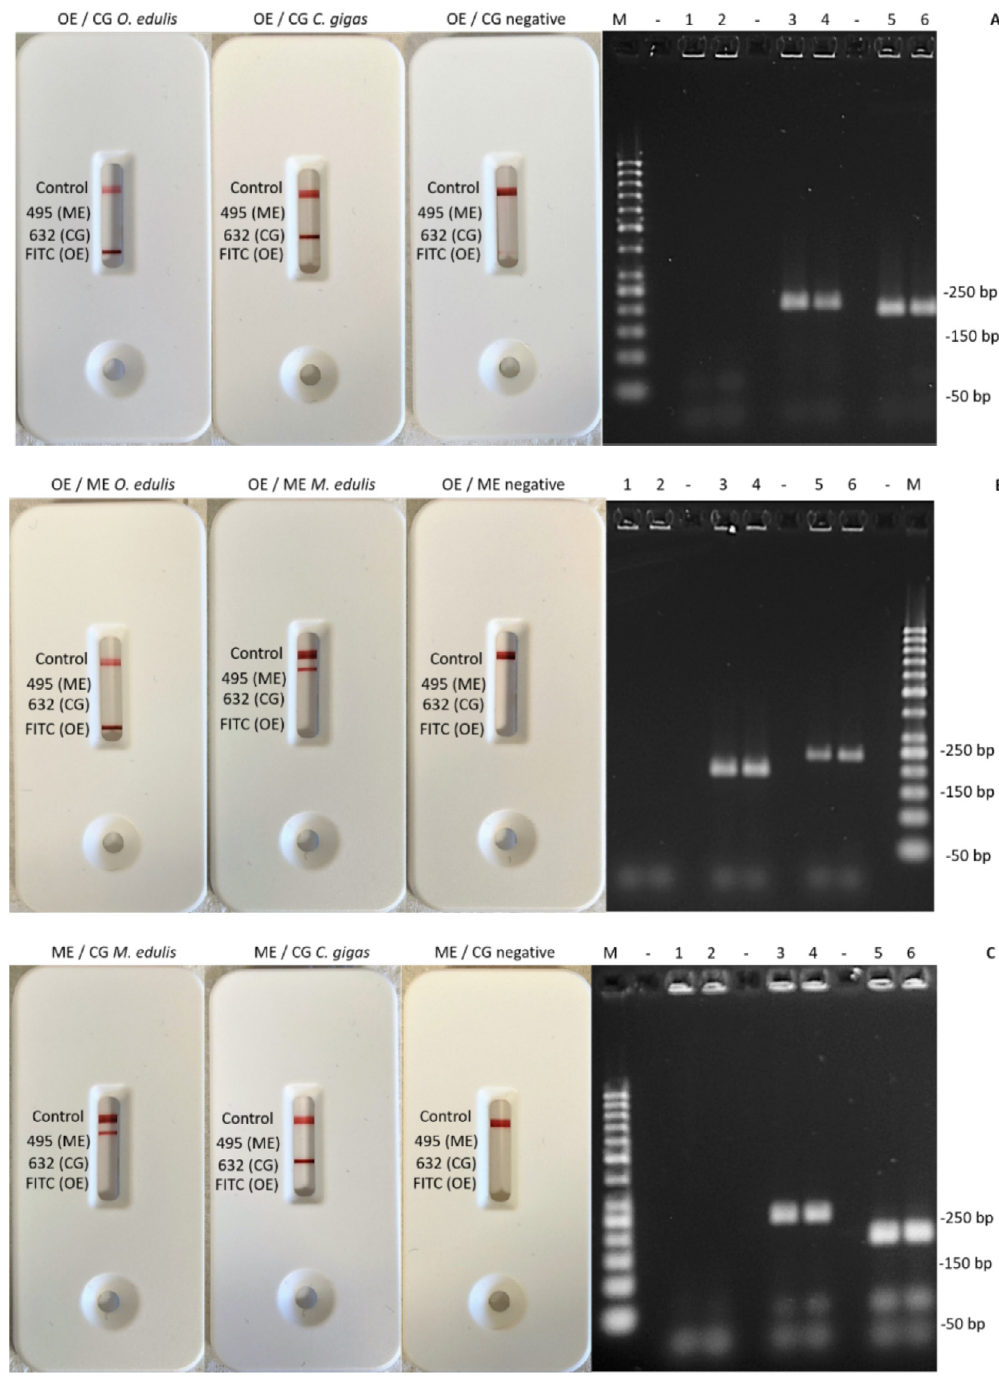
Fig. 3. PCR-nucleic acid lateral fl ow immunoassay (NALFIA) with a combination of two primer pairs and one DNA template. The label on the left side of every pair of cartridges is indicating the test line for the existence of Ostrea edulis (FITC OE), Crassostrea gigas (632 CG), and Mytilus edulis (495 ME). The most upper line on the cartridges is indicating the control line of each NALFIA. Primer combinations above the cartridges are indicated with OE, CG, and ME for the primers of O. edulis , C. gigas , and M. edulis , respectively. Part A of the fi gure shows OE and CG primers in combination with O. edulis DNA (left cartridge), C. gigas DNA (middle cartridge) and a negative control with no DNA template. Part B of the fi gure shows OE and ME primers in combination with O. edulis DNA (left cartridge), M. edulis DNA (middle cartridge) and a negative control with no DNA template. Part C of the fi gure shows ME and CG primers in combination with M. edulis DNA (left cartridge), C. gigas DNA (middle cartridge) and a negative control with no DNA template. The image of the 3% agarose gel electrophoresis shows the quality control of the PCR products. The scheme of each gel slots: 1: non-template replicate 1, 2: non-template replicate 2, 3: left cartridge replicate 1, 4: left cartridge replicate 2, 5: middle cartridge replicate 1, 6: middle cartridge replicate 2, M: 50 bp marker, ( (cid:2) ):